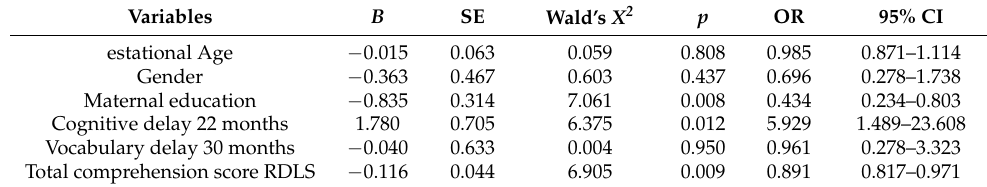
Table 9. Logistic regression analysis: predictors of grammar understanding delay (CEG) at 60 months of age.